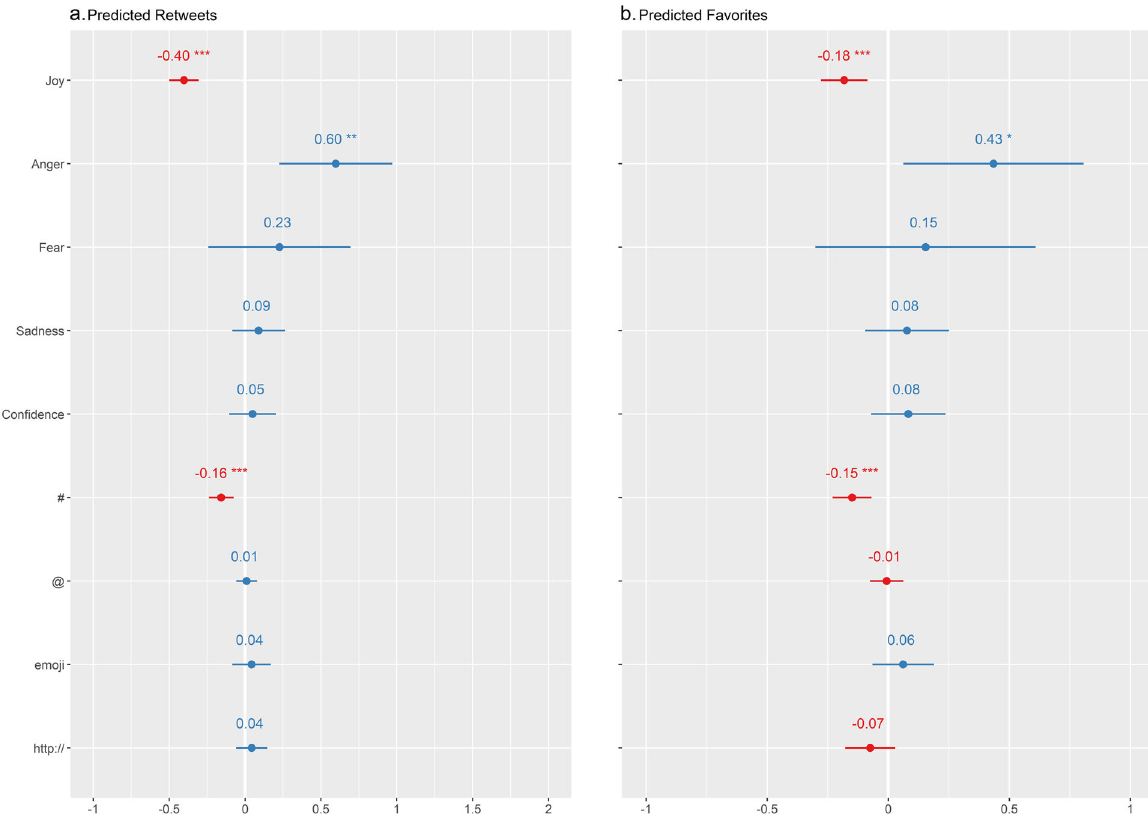
Fig. 4 Predicted effects on Twitter engagement among Republicans. Predicted effects on a retweet and b favorite counts leading up to the 2018 US mid- term elections (09 October – 06 November 2018) among Republicans. Conditional R 2 (0.794) and Ω 2 (0.792) measure the model ’ s variance between the observed and the predicted response. Recoded #, @, URL and emoji to dummy variables ( x = 1 for a given tweet contains the feature). Bands re fl ect 95% CIs with follower/friend counts, race competitiveness and incumbency as offset variables. * p < 0.05, ** p < 0.01, and *** p < 0.001 based on an F